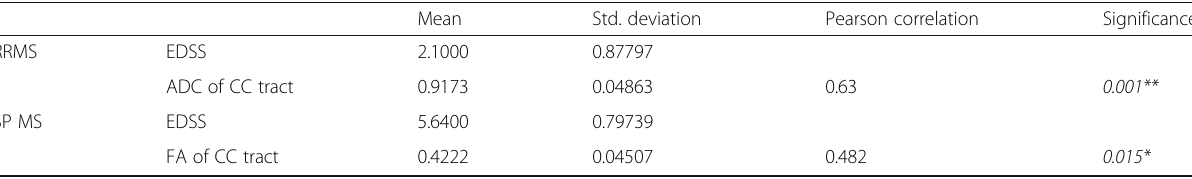
Table 5 Correlation between average ADC/FA of corpus callosum tract and EDSS in both MS groups Mean Std. deviation Pearson correlation